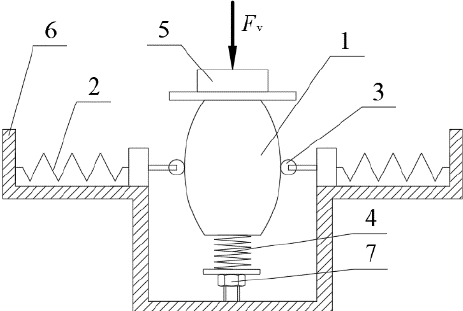
Figure 7. Schematic design of the HSLDS mount based on target force curve (1 – roller guide support, 2 – lateral spring, 3 – roller, 4 – vertical spring, 5 – isolated object, 6 – fitting seat, 7 – height adjuster).